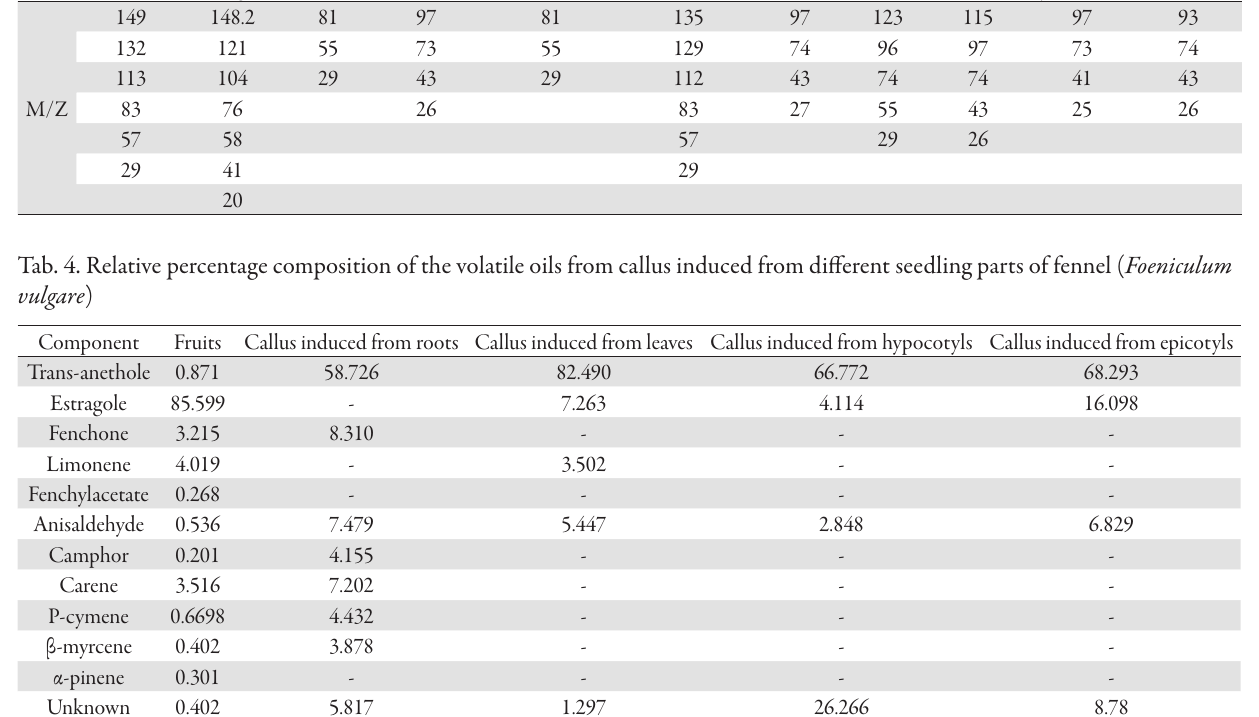
Tab. 3. The parent and degradable M/Z ions of essential oils of fennel ( Foeniculum vulgare ) T-anethole Estragole Fenchone Limonene Fenchyl acetate Anisaldehyde Camphor Carene P-cymene β-myrcene